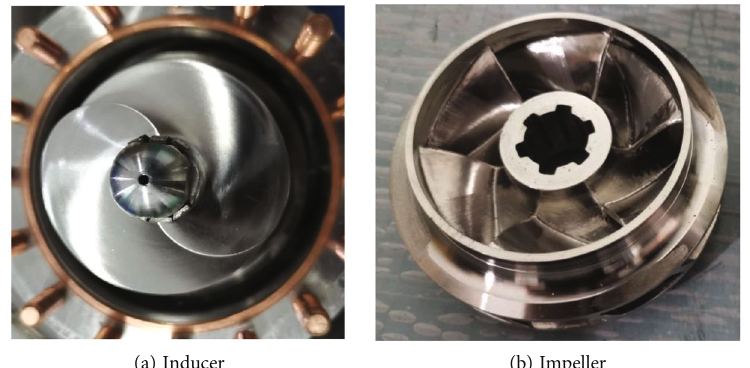
Figure 1: Inducer and impeller after hydraulic tests.